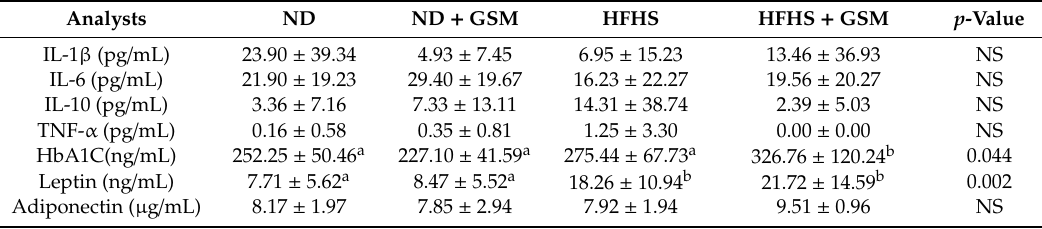
Table 3. Inflammatory and metabolic markers in rat plasma at the end of the